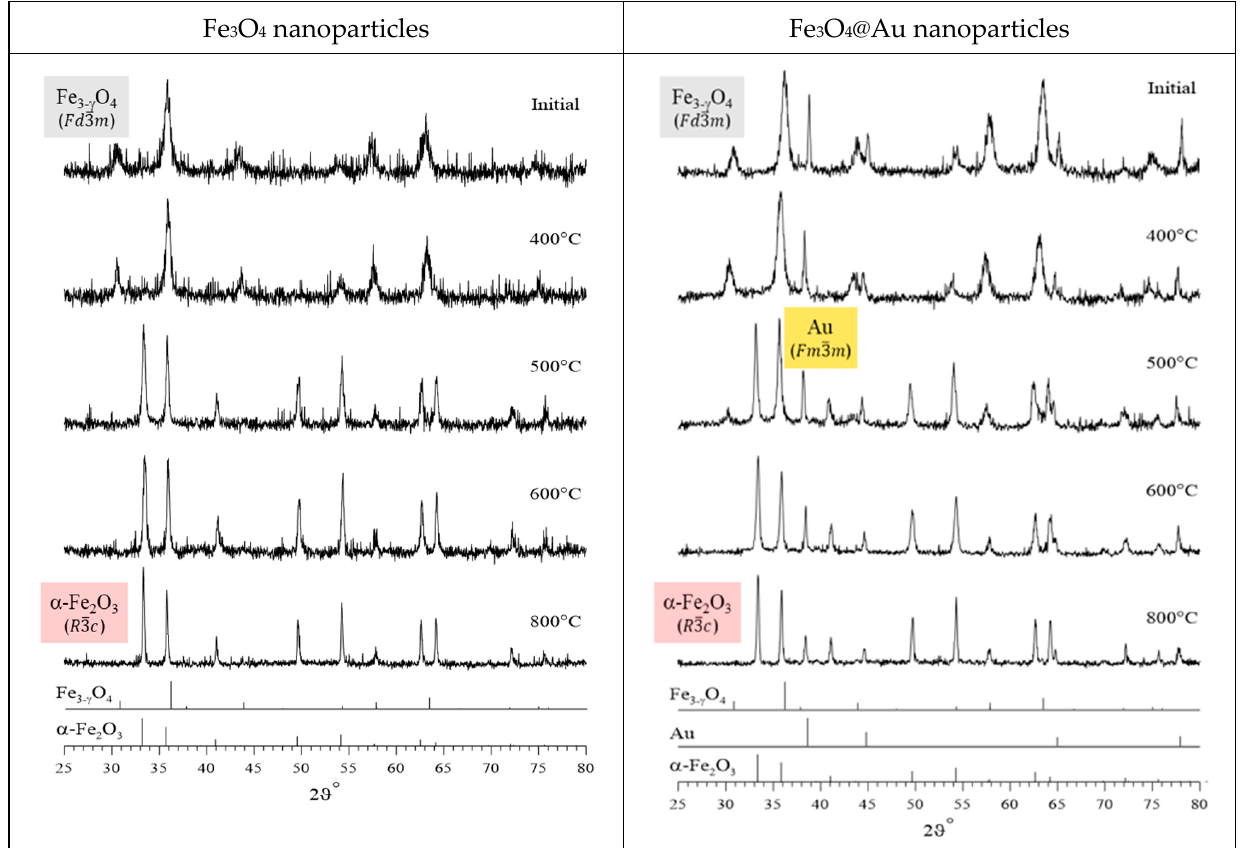
Figure 5. X-ray diffraction patterns of initial and annealed at temperatures of 400 °C, 500 °C, 600 °C, and 800 °C Fe 3 O 4 and Fe 3 O 4 @Au nanoparticles.